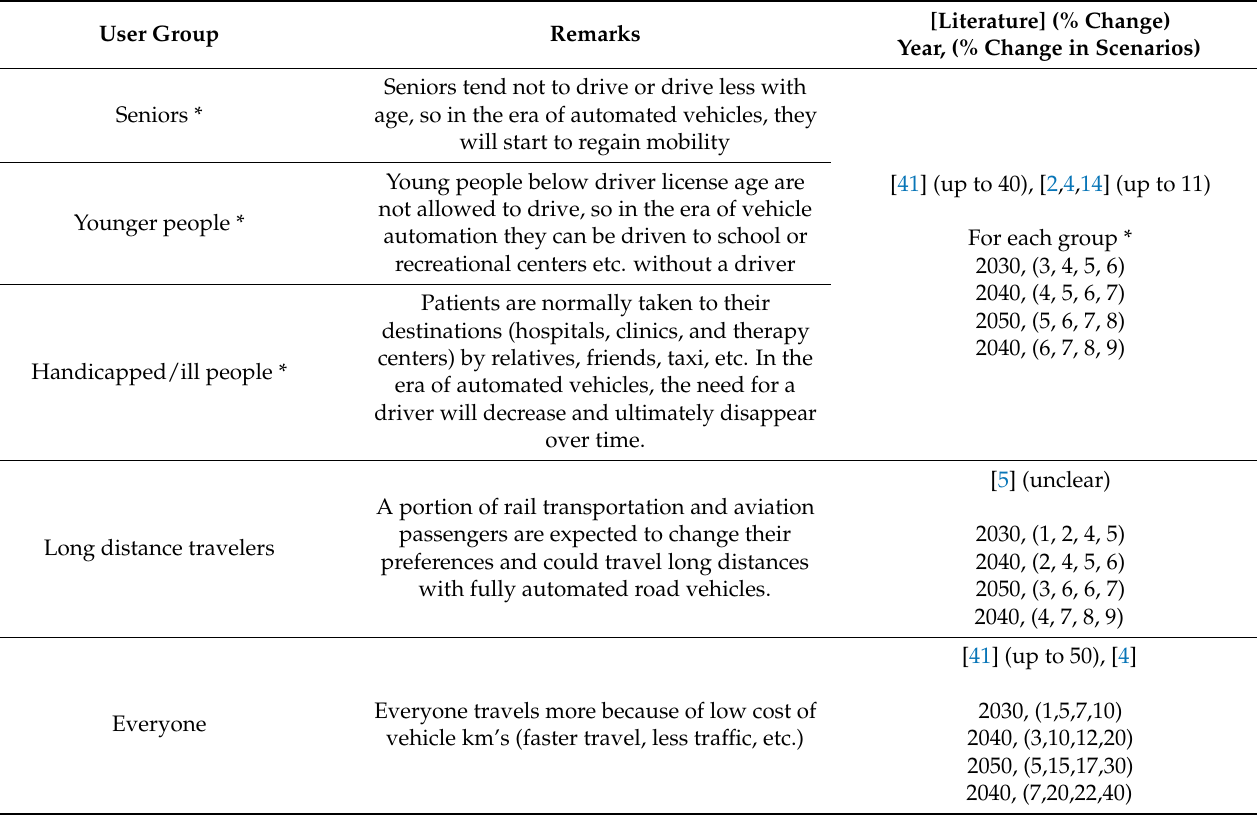
Table 3. Effects of SAEV on different user groups.